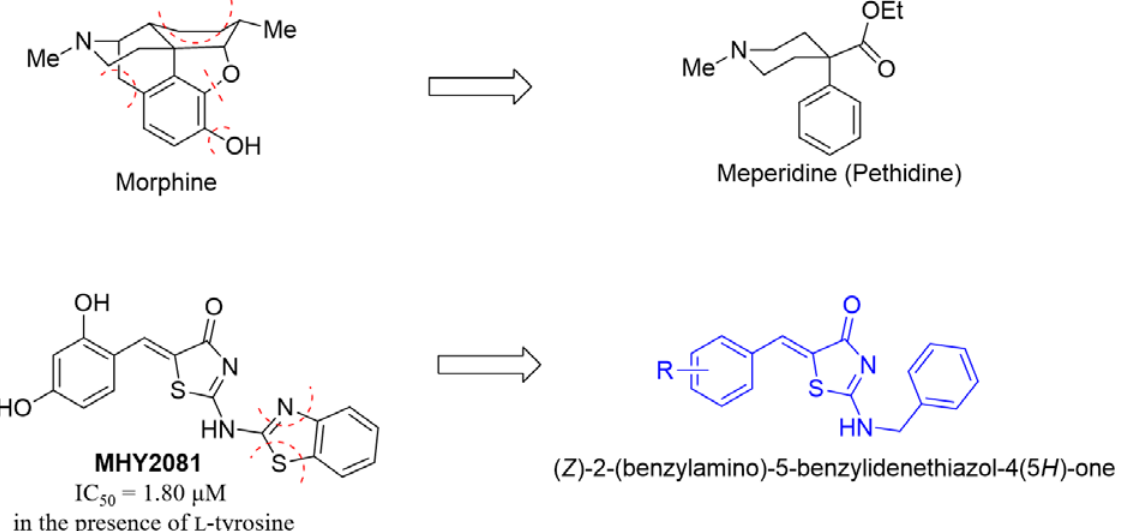
Figure 1. Pethidine designed from morphine via a simplified approach, and ( Z )-2-(benzylamino)-5-benzylidenethiazol-4(5 H )-one (BABT) derivatives designed based on the MHY2081 chemical struc- ture.